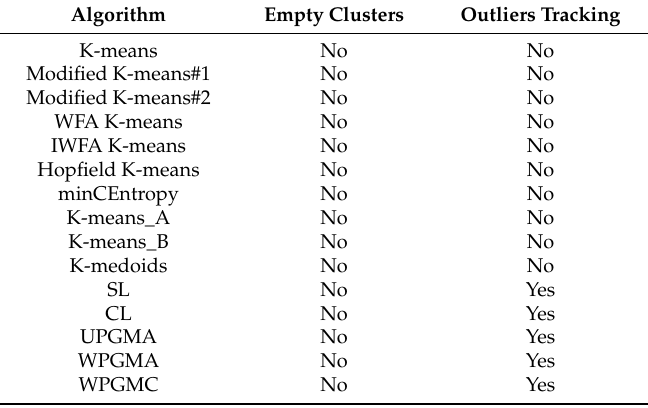
Table 10. Algorithms comparison in terms of empty clusters formation and outliers